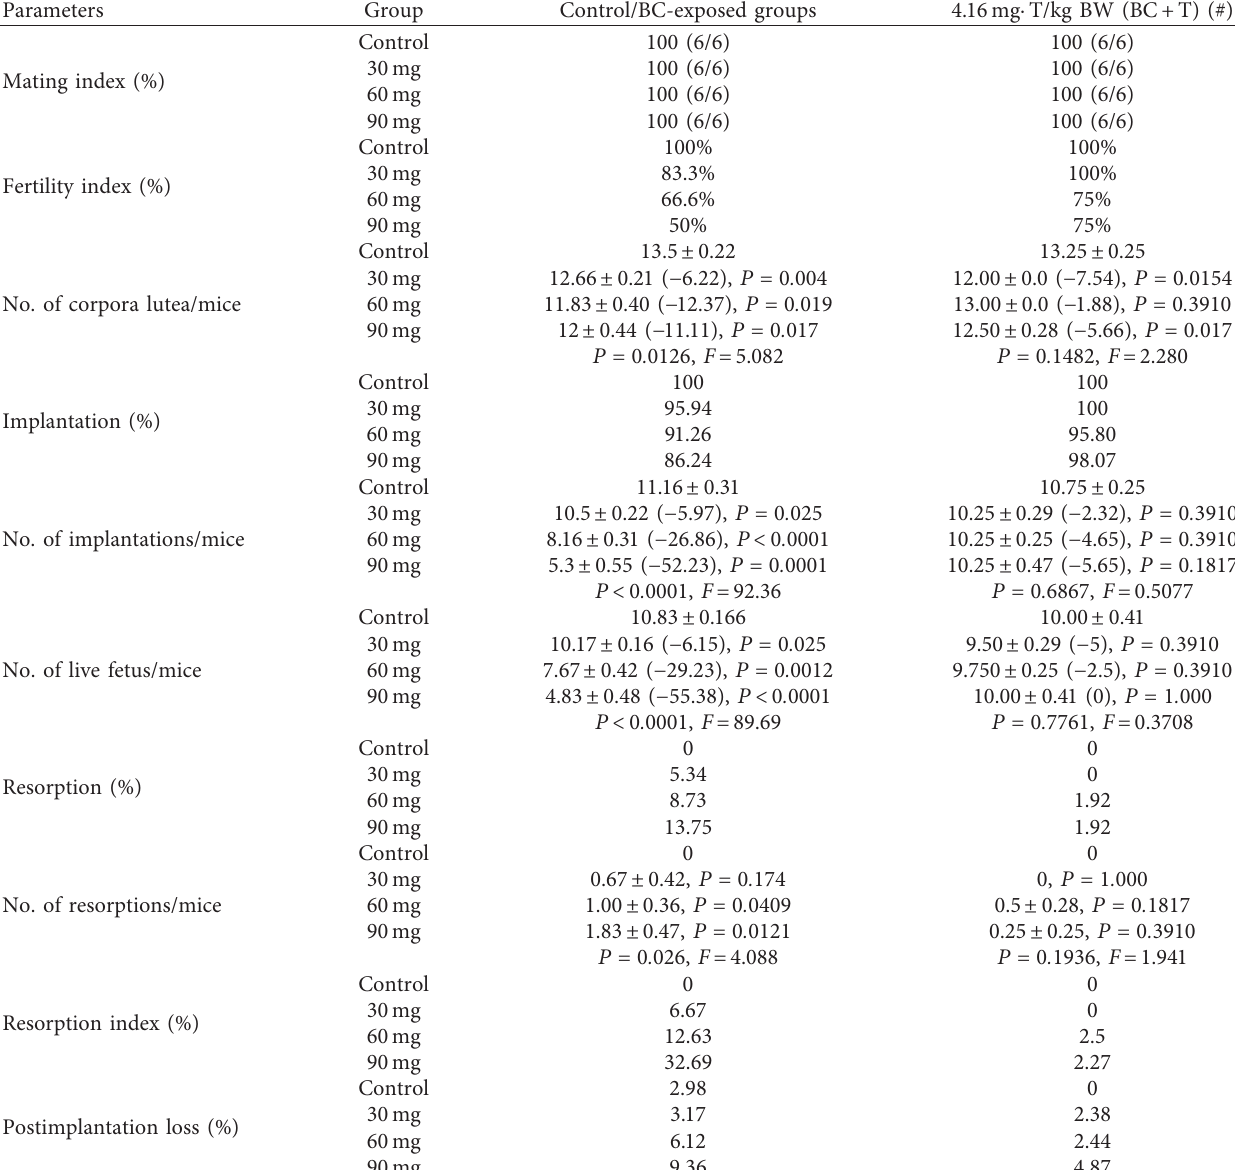
Table 1: Administration of testosterone (T) on reproductive performance of adult male mice exposed to baicalein (BC)